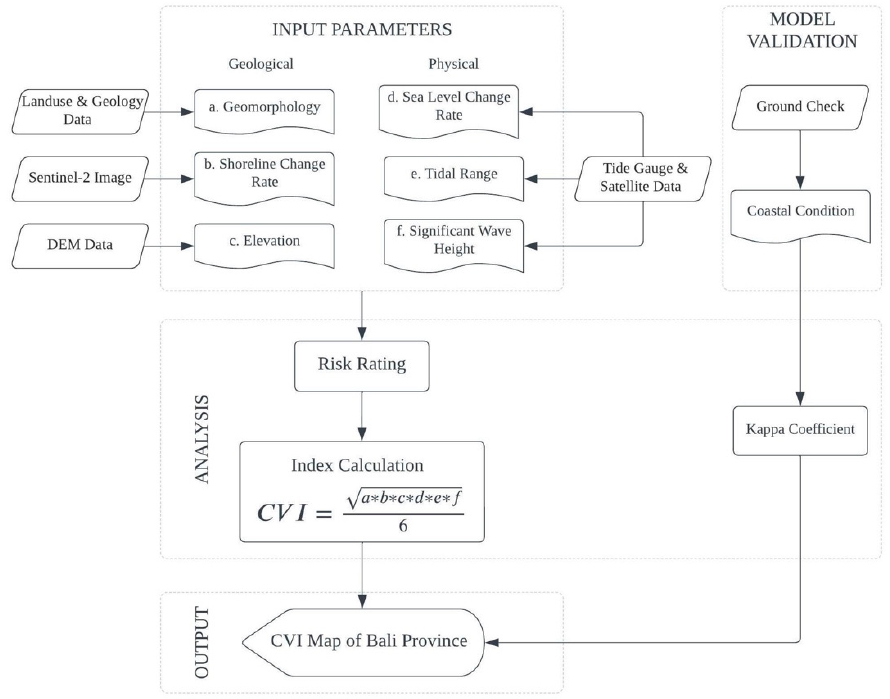
Figure 2. Flow chart outlining the process to obtain CVI map.